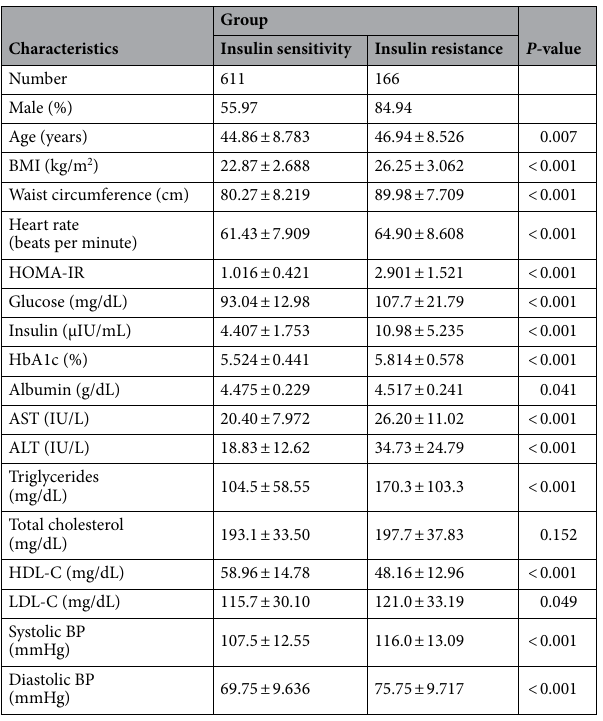
Table 1. Characteristics of participants in the Kangbuk Samsung Health cohort. * ALT Alanine aminotransferase, AST Aspartate aminotransferase, BMI Body mass index, BP Blood pressure, HbA1c Hemoglobin A1c, HDL-C High-density lipoprotein cholesterol, HOMA-IR Homeostatic model assessment of insulin resistance index, LDL-C Low-density lipoprotein